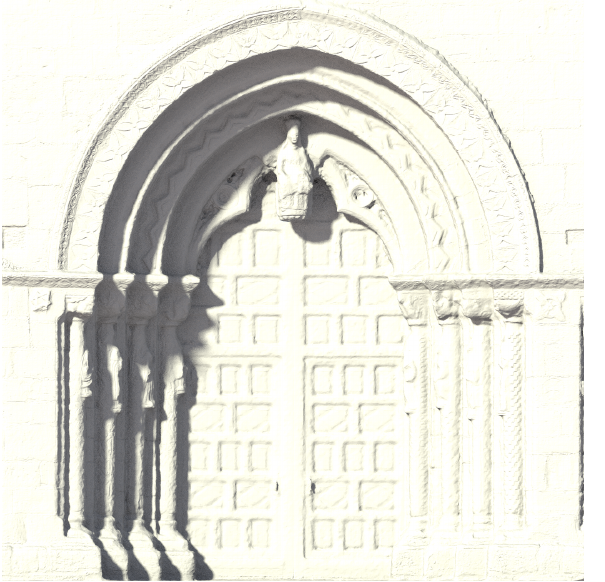
Figure 11: Final render of the fully composed orthophoto with a synthetic slanted illumination that highlights the fine relief details of the texture. Enhanced detail is achieved thanks to the photo- metric stereo method.